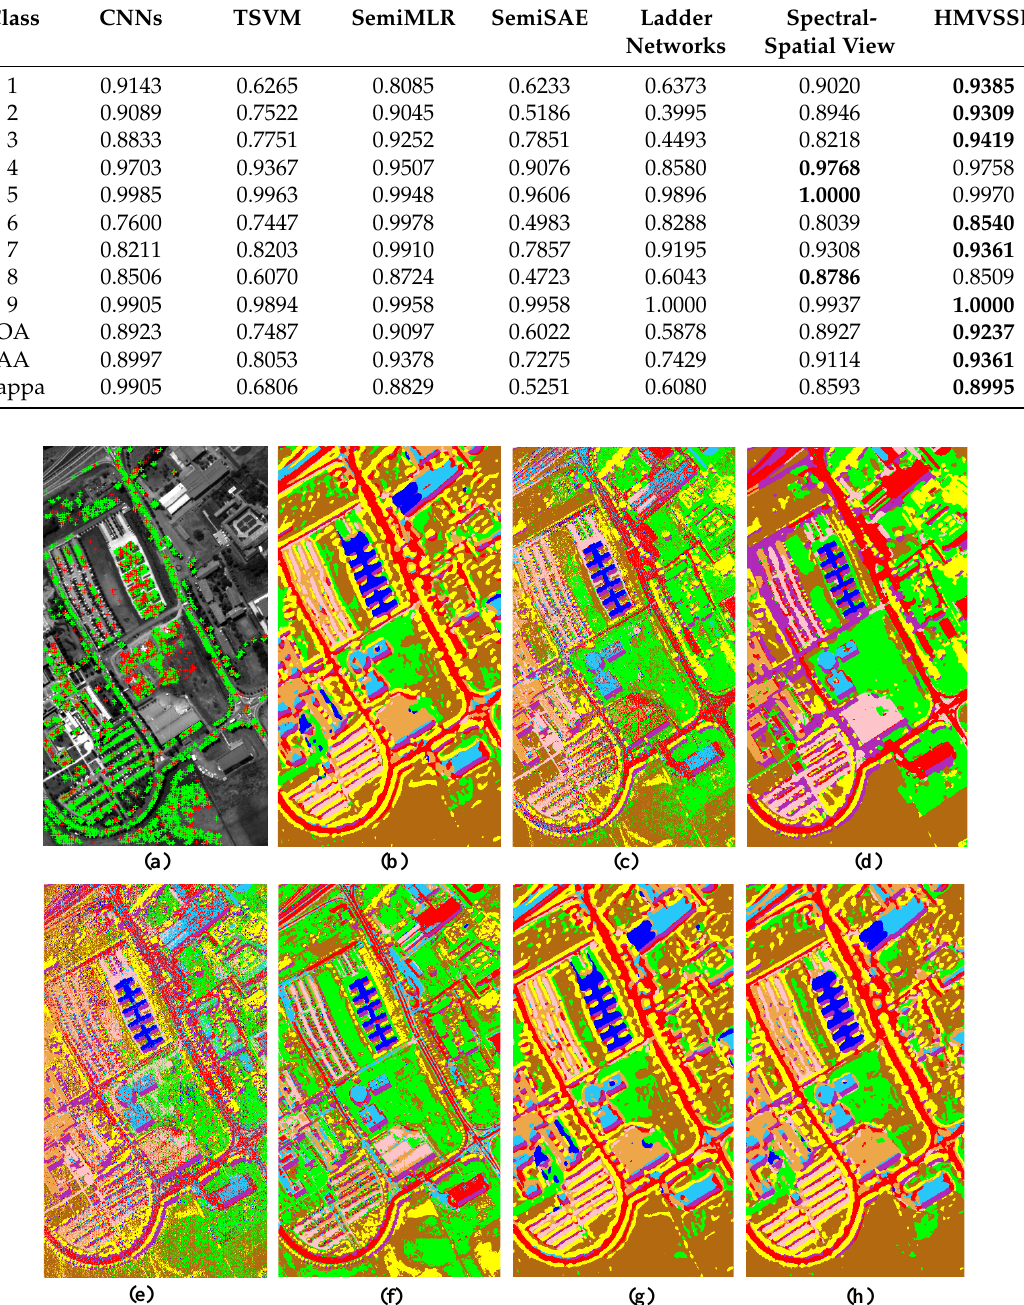
Table 4. Classification accuracy of the compared methods on Pavia University data.